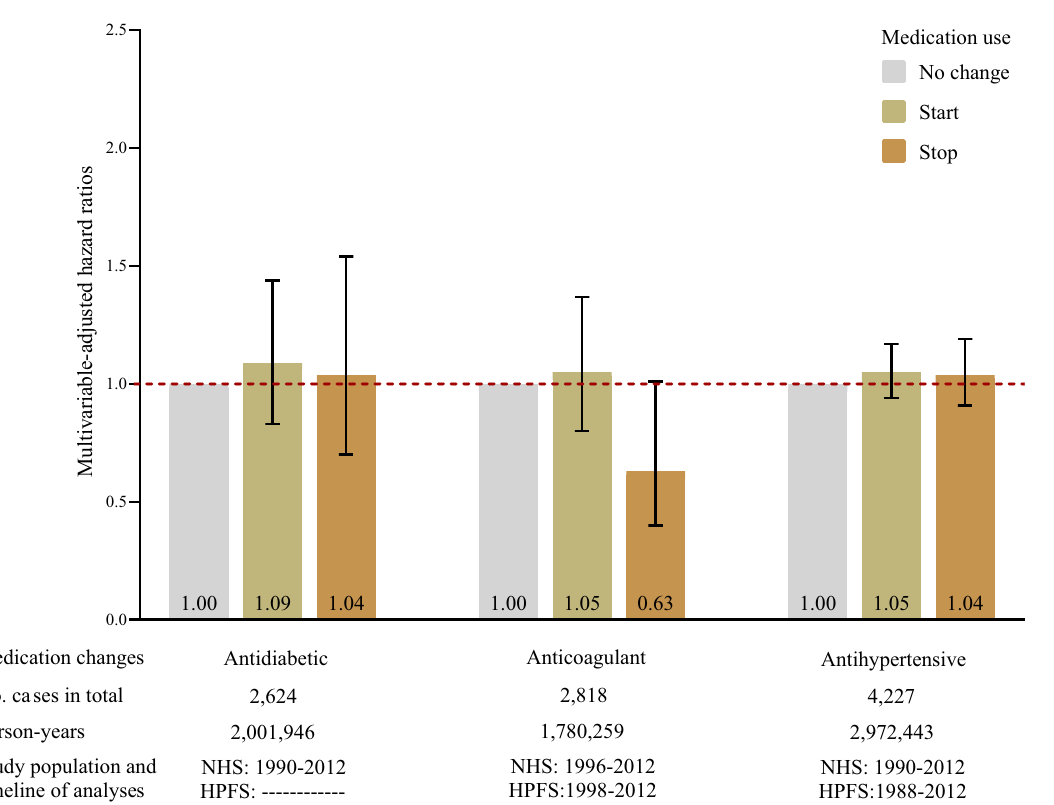
Fig. 3 | Recent change in medication use and 2-year risk of other digestive systemcancerdiagnoses. Othercancersofthedigestivesystem,includingcancers of esophagus, stomach, small intestine, colorectum, anus, liver, and gallbladder. Data are presented as the hazard ratios obtained from Cox proportional hazards models in analyses of antidiabetic ( n =101,294 biologically independent partici- pants, 2624 incident other digestive system cancer cases), anticoagulant ( n =128,718 biologically independent participants, 2818 incident other digestive system cancer cases), and antihypertensive ( n =148,973 biologically independent participants, 4227 incident other digestive system cancer cases) medication